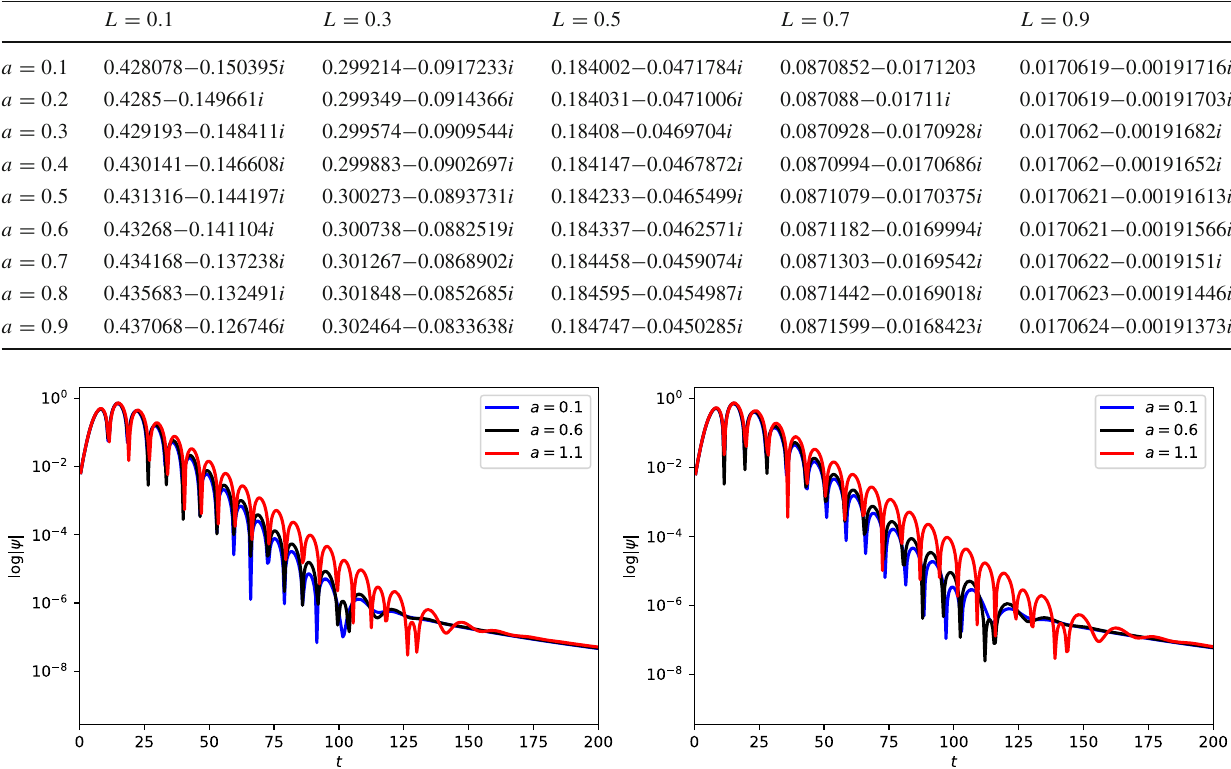
oscillation frequencies and damping rates of both the